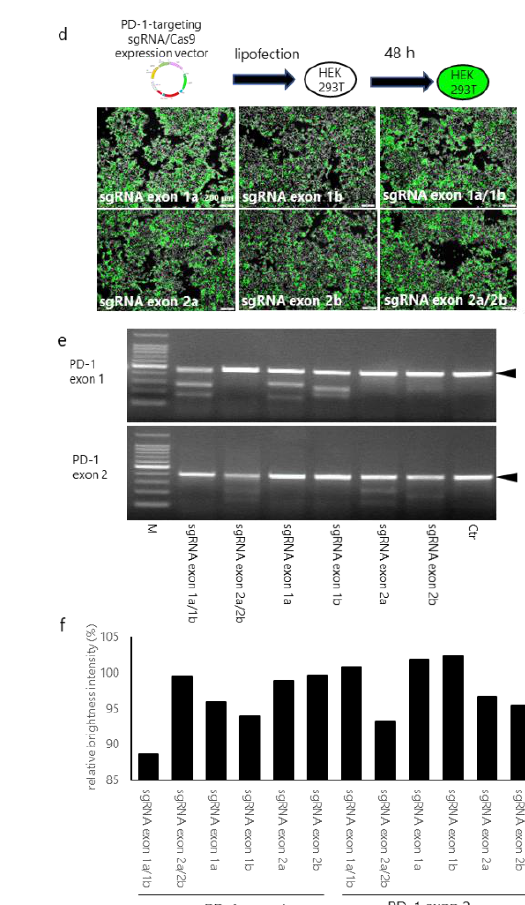
Figure 1. Evaluation of human PD-1- (programmed cell death protein 1)-targeting CRISPR / Cas9 expression vectors in HEK293T cells. ( a ) Schematic representation of the CRISPR / Cas9 expression vector ( b , c ). Schematic diagrams of small-guide RNAs (sgRNAs) targeting the PD-1 exon 1 and exon 2 loci. The sgRNA target sites are underlined. Bold letters indicate the proto-spacer adjacent motif (PAM) sequence, which is recognized by Cas9. ( d ) Lipofection of PD-1-targeting CRISPR / Cas9 expression vectors into HEK293T cells. One or two PD-1-targeting sgRNA / Cas9 expression vectors (total, 2 µ g DNA) were transfected into HEK293T cells and cultured for 48 h. The images were acquired with a fluorescence inverted microscope. ( e ) PD-1-targeting CRISPR / Cas9 expression vector-mediated DNA cleavage of human PD-1 gene locus (findings from T7EN1-based cleavage assays). The upper and lower panels depict the resolvase-digested PCR product of the PD-1 exon 1 and exon 2 regions, respectively. ( f ) Percent intensity of undigested PCR products of PD-1, as determined by densitometric analysis. Relative brightness intensity (RBI) was calculated by dividing the brightness intensity of each band by the brightness intensity of the control band.